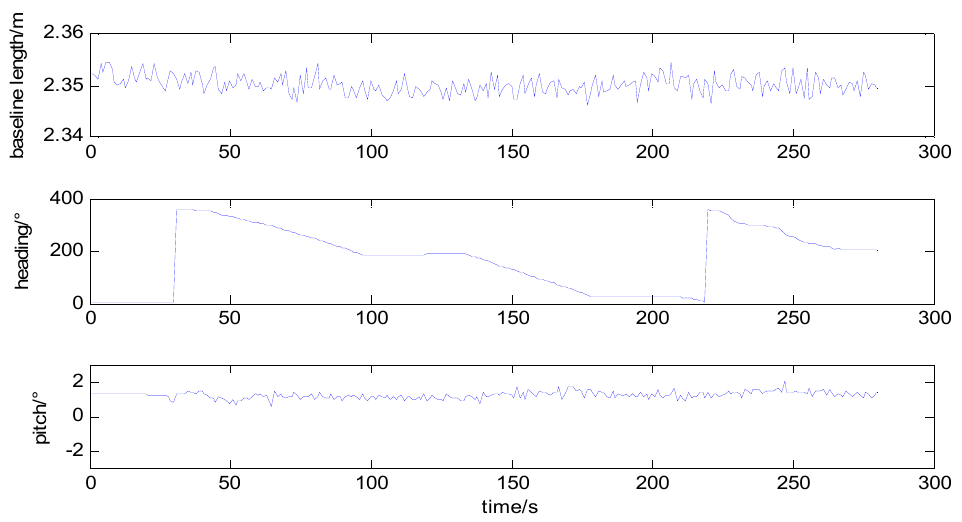
Figure 5. Heading and pitch determination during the test.